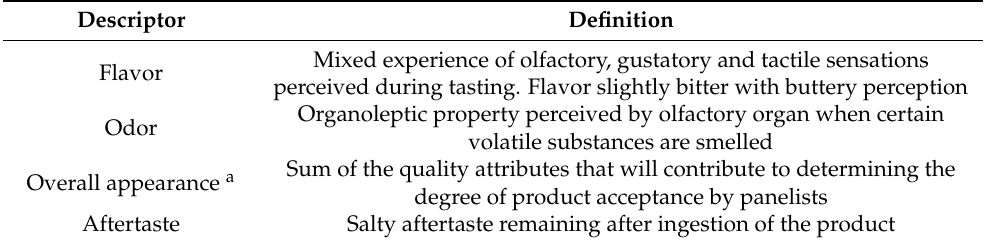
Table 3. Descriptors used in the quantitative descriptive sensory analysis of goat